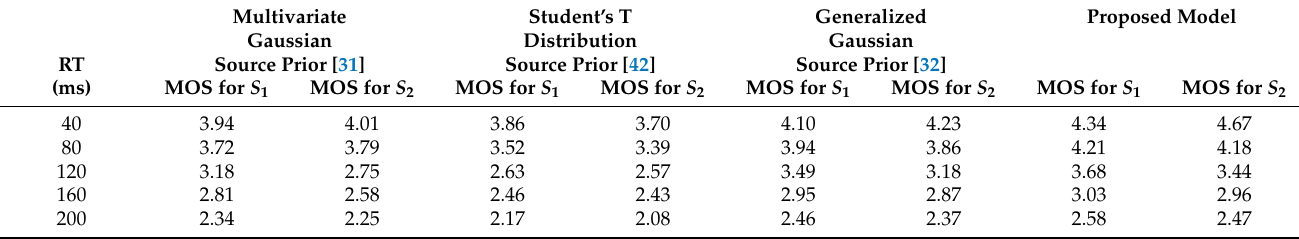
Table 6. Average MOS results of the subjective evaluation for the first model shown in Figure 1 with variable RT for multistage BSS models having different source priors.